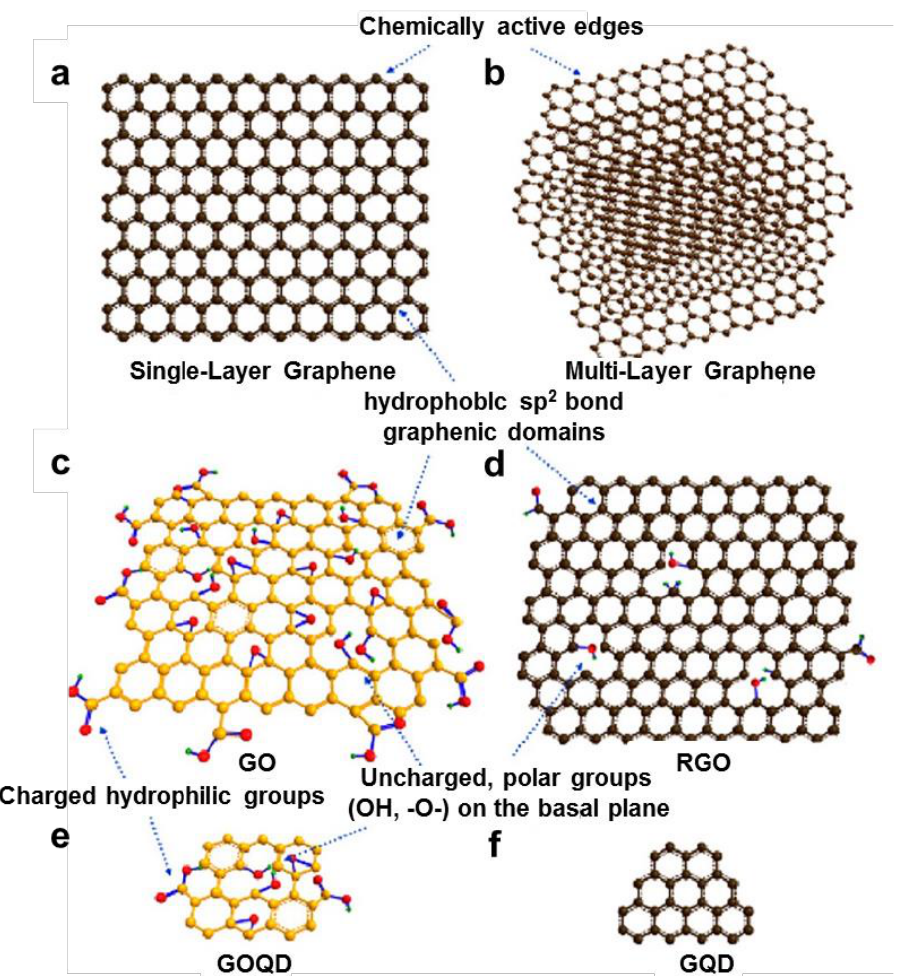
Figure 2. ( a ) Single-layer graphene, ( b ) multilayer graphene, ( c ) GO, ( d ) RGO, ( e ) GOQD, ( f ) GQD [19]. Copyright © 2021, The American Chemical Society.